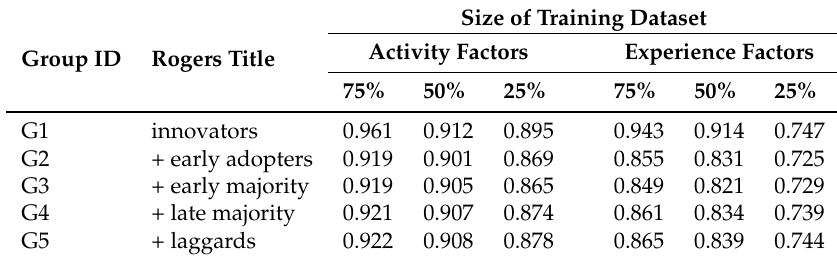
Table 6. Accuracy of classification results with the use of Activity and Experience Factors for combined adoption